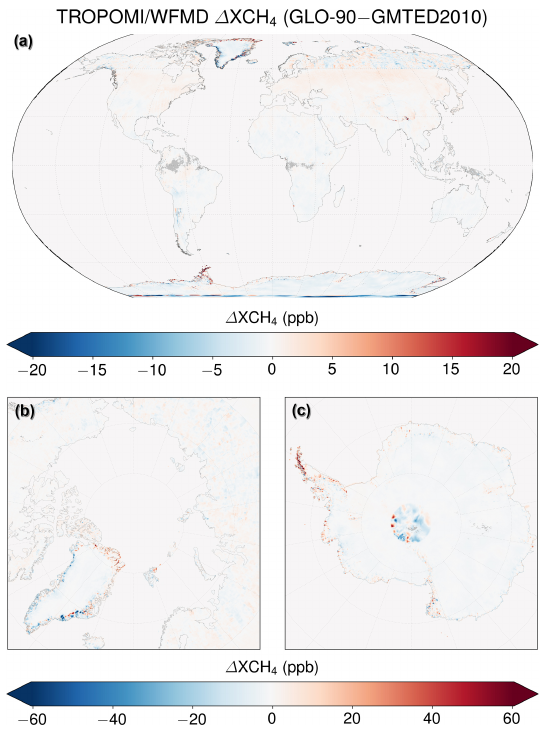
Figure 6. Global differences (a) in XCH 4 when substituting the GMTED2010 digital elevation model with GLO-90. The largest differences are in the (b) Arctic, in particular Greenland, and (c)